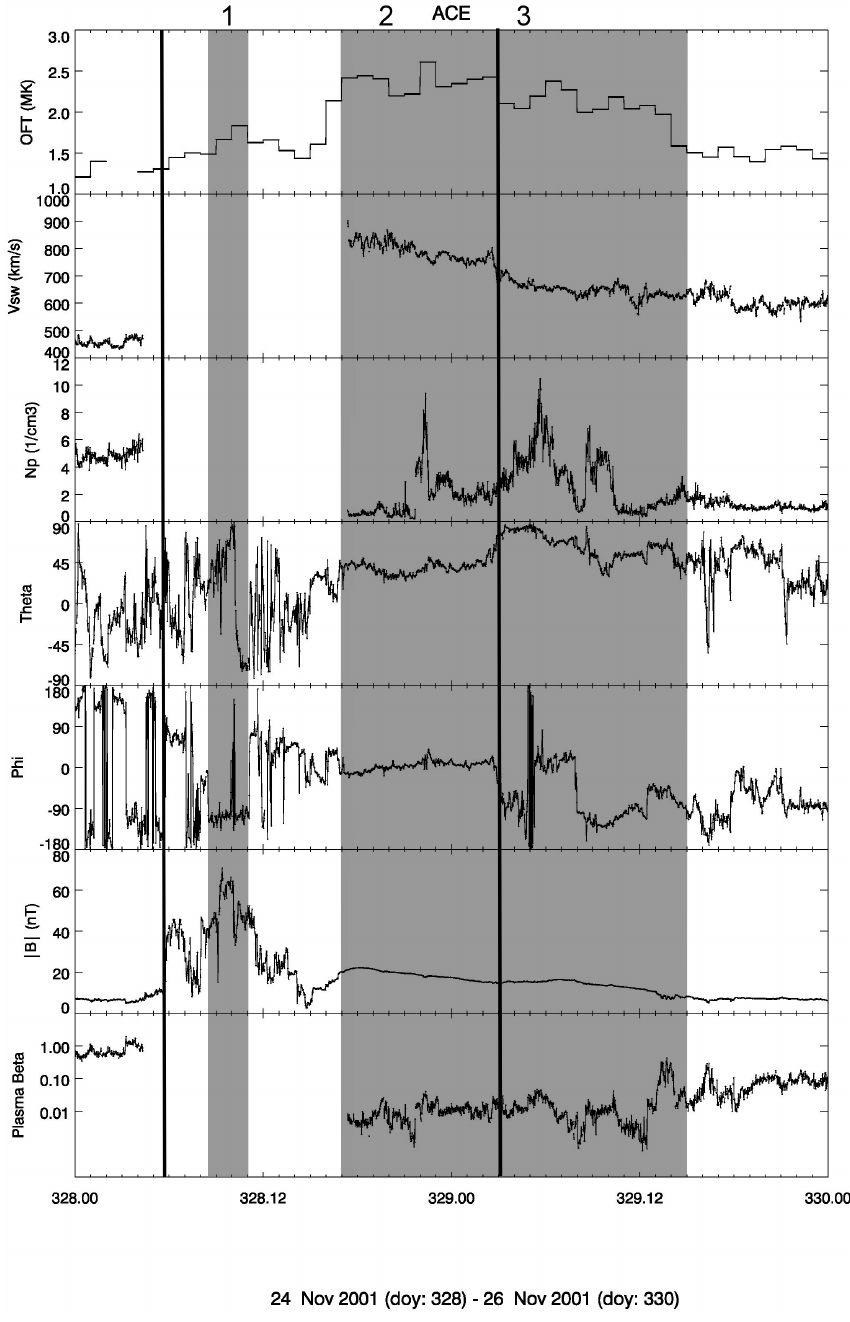
Fig. 5. ACE observations of the events in November 2001. The first vertical line marks the arrival of a shock (corroborated with Wind plasma data, not shown here). The first shading region shows an atypical region within the sheath. The second, bigger, shaded region represents the ejection, with the vertical line close to the middle separating a first part which shows MC characteristics from a second part which presents a non-cloud ICME